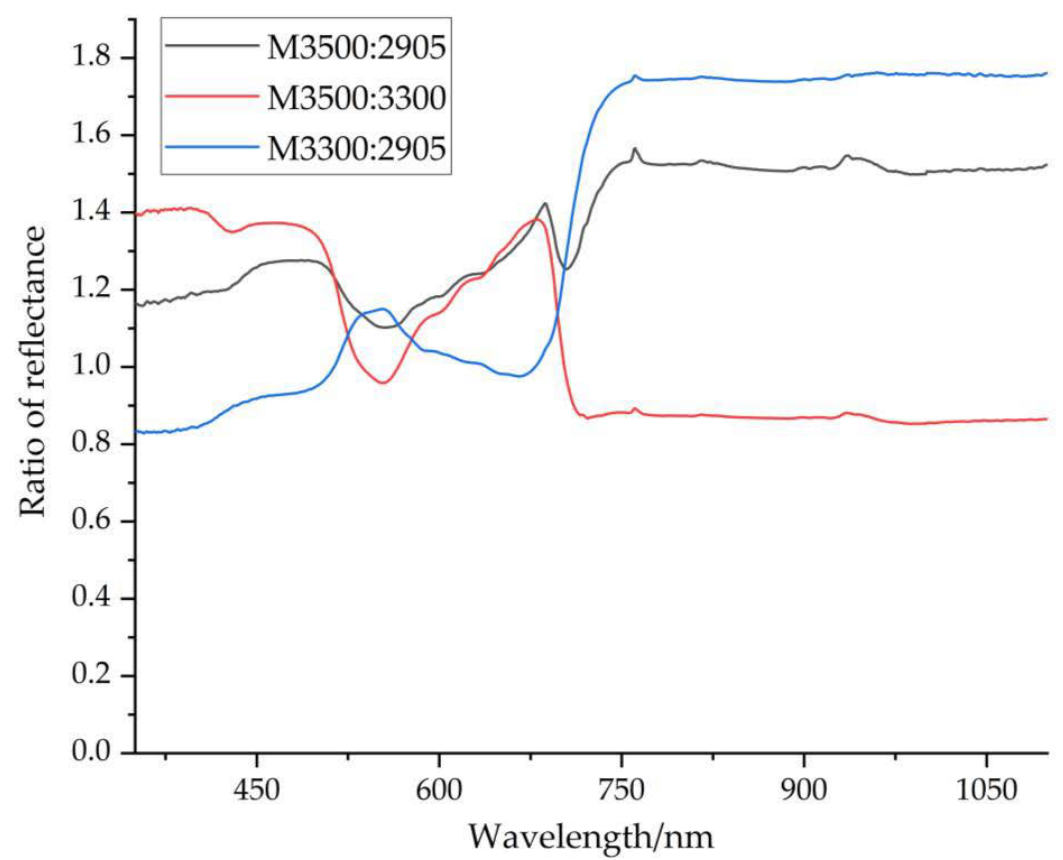
Figure 4. Spectral reflectance ratio of Quercus aquifolioides leaves at different altitudes.